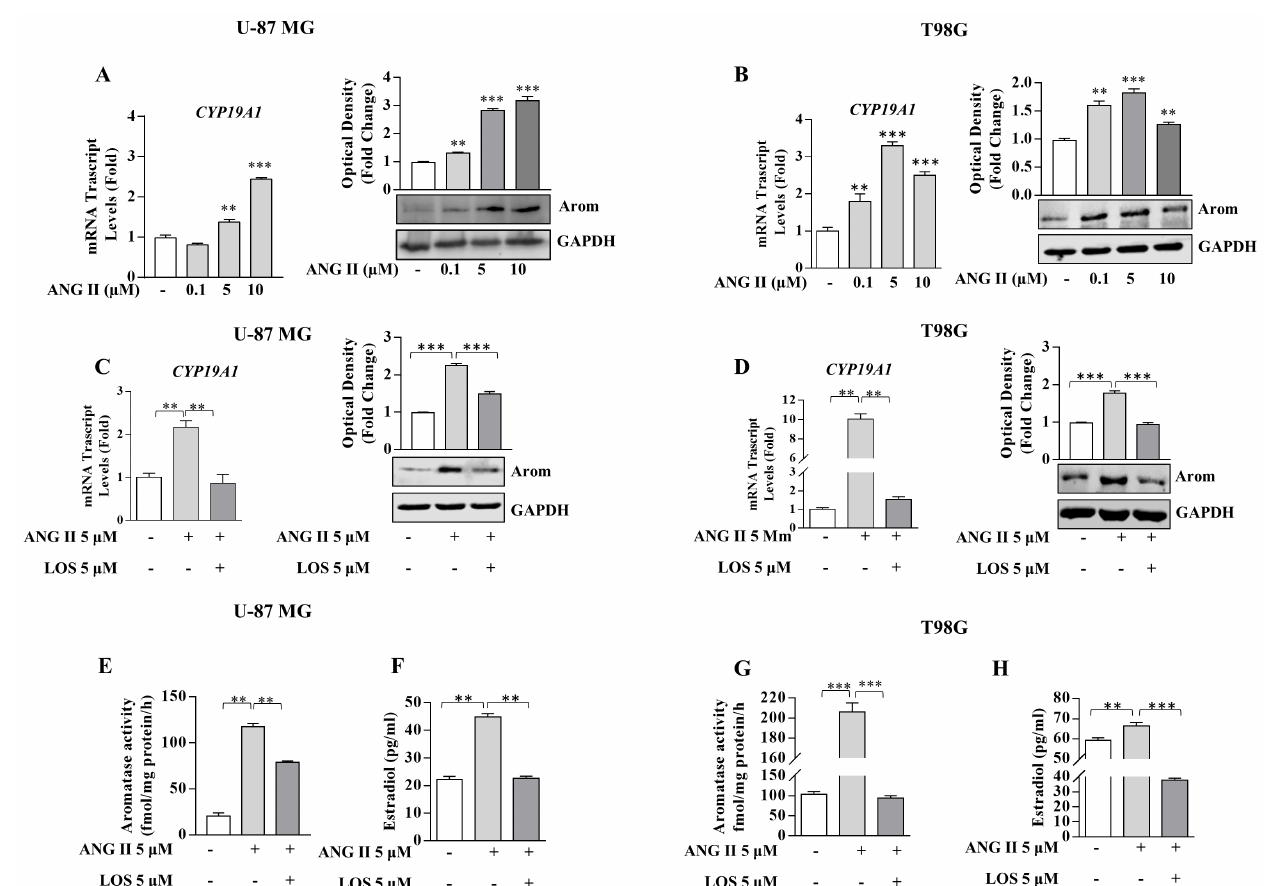
Figure 7. Effects of Ang II and LOS on aromatase expression and activity in U-87 MG and T98G glioblastoma cells. ( A , B ) Real-time RT-PCR and immunoblotting assay for CYP19A1 mRNA and protein expression in U-87 MG and T98G glioblastoma cells, treated with vehicle ( − ) or the Ang II 0.1, 5, and 10 µ M for 24 h. GAPDH was used as a loading control. The histograms represent the mean average ± SD of three separate experiments in which band intensities were evaluated in terms of optical density arbitrary unit and expressed as fold change over vehicle ( − ) for Ang II treatment. ( C , D ) CYP19A1 mRNA and protein expression in U-87 MG and T98G glioblastoma cells treated with vehicle ( − ) and Ang II 5 µ M alone or in combination with LOS 5 µ M for 24 h. The histograms represent the mean average ± SD of three separate experiments in which band intensities were evaluated in terms of optical density arbitrary unit and expressed as fold change over vehicle ( − ) for Ang II treatment or fold change over Ang II for Ang II in combination with LOS, 5 µ M. GAPDH was used as a loading control. ( E , G ) Aromatase activity in U-87 MG and T98G glioblastoma cells treated with vehicle ( − ) and Ang II 5 µ M alone or in combination with LOS 5 µ M for 24 h. ( F , H ) ELISA for Estradiol secretion in U-87 MG and T98G glioblastoma cells treated with vehicle ( − ) and Ang II 5 µ M alone or in combination with LOS 5 µ M for 24 h. Data represent the mean ± SD of three different experiments, each performed in triplicate. ** p < 0.01; *** p <